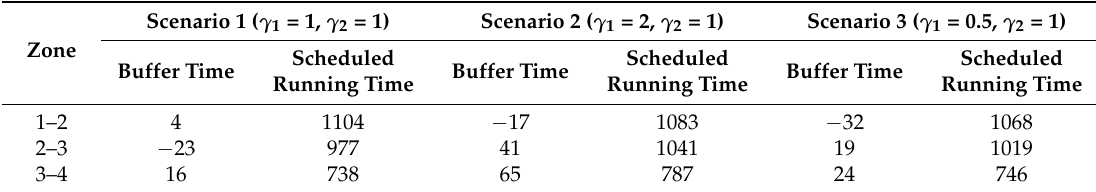
Table 8. Solution based on time control point strategy. Unit: